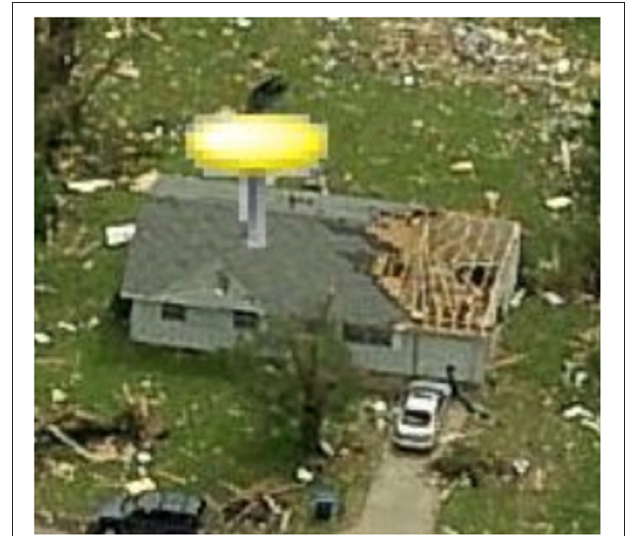
Structural Damage. Image resolution and quality reduced for publication. Image courtesy of Eagleview Technologies,